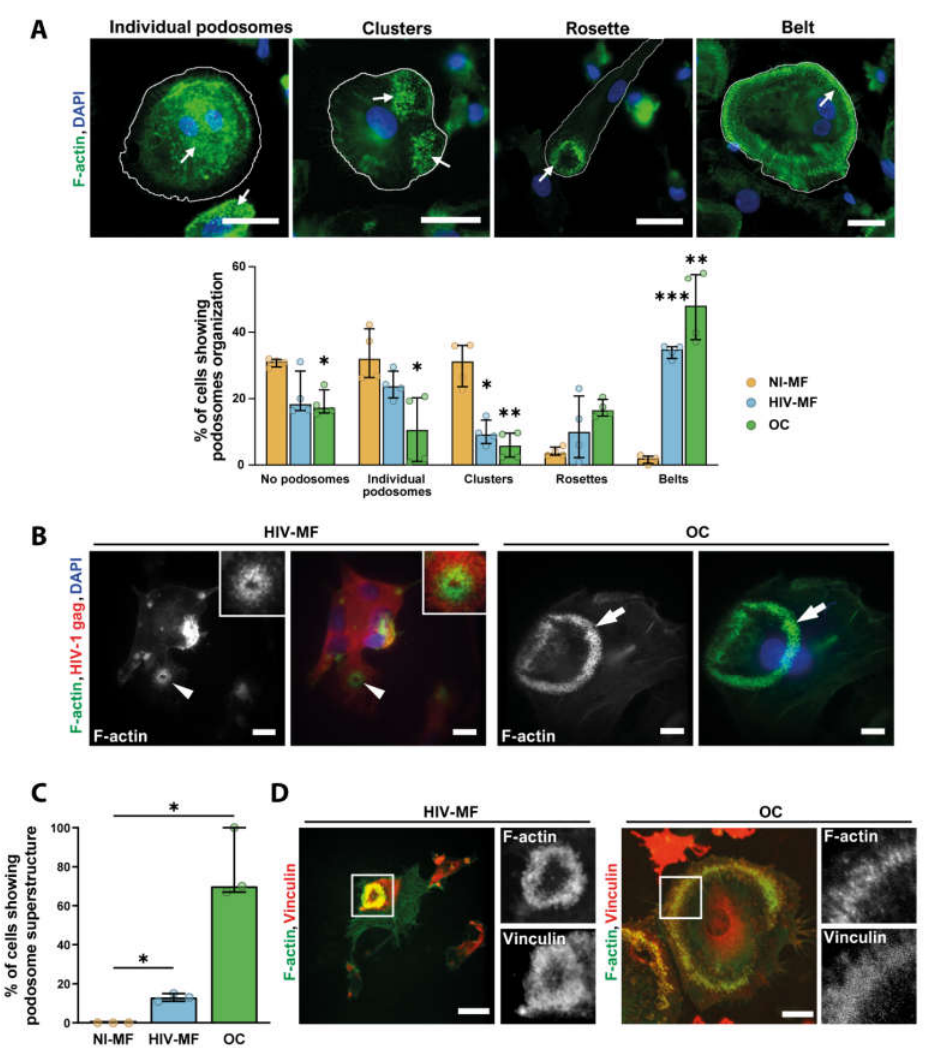
Figure 2. HIV-1 infection of MF promotes podosome organization into super-structures. ( A ) Top: Representative IF images of di ff erent podosome organizations in MF or OC seeded on glass coverslips, after staining for F-actin (green) and nuclei (DAPI, blue). White arrows show podosome structures. Scale bar, 20 µ m. Bottom: Quantification of the di ff erent podosome organizations in non-infected MF (NI-MF), HIV-1-infected MF (HIV-MF, ADA strain), and OC represented in percentage of total cells. Histograms represent median and error bars are in interquartile range, n = 4 donors, 300 cells analyzed per donor. ( B ) Monocytes were seeded on bone slices and di ff erentiated into MF or OC. Then, at day 7, MF were infected with HIV-1 (NLAD8 strain) and all cells were fixed at day 14. Left: representative IF images of podosome super structures in HIV-MF (arrowheads) and OC (arrows) stained for HIV-1 gag (red), F-actin (green), and nuclei (DAPI, blue). Scale bar, 5 µ m. Inserts show two-fold magnification of the podosome structure in HIV-MF. ( C ) Quantification of the percentage of MGC showing podosome organization on bones, evaluated by IF. Histograms represent median and error bars are in interquartile range, n = 3 donors, 100 cells analyzed per condition. ( D ) Representative image of podosome super-structures formed by HIV-MF (NLAD8 strain, left) or OC (right) seeded on bone slices, after staining for F-actin (green) and vinculin (red). Scale bar, 10 µ m. Inserts show two-fold magnification of white square. * p ≤ 0.05; ** p ≤ 0.01; *** p ≤